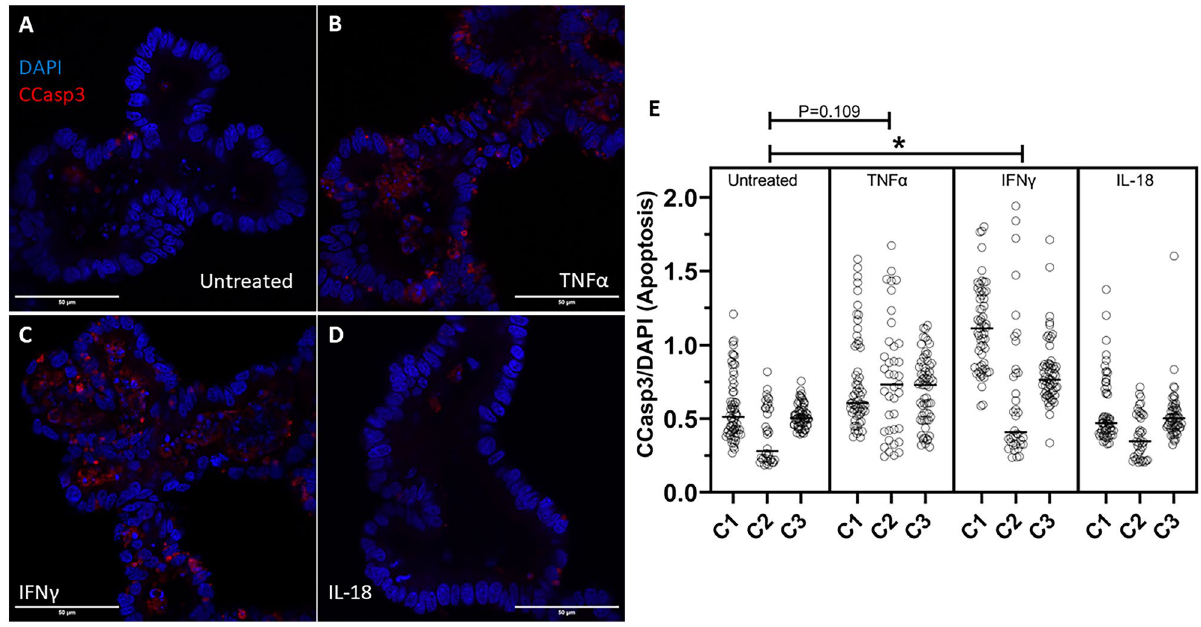
Figure 7. Cytokine treatment alters apoptosis. ( A–D ) Representative confocal images of cytokine-treated bovine intestinal organoids stained for Cleaved Caspase-3 (CCasp3) (Alexa Fluor 594) and DAPI using a ×63 objective lens. Scale bars denote 50 µm. ( E ) Area of intraluminal CCasp3 normalized to DAPI measured by confocal microscopy. C1, C2, and C3 indicate individual enteroid lines. IFNγ induces a rise in apoptotic cells (p = 0.0325) determined by nested ANOVA Holm-Šídák post hoc